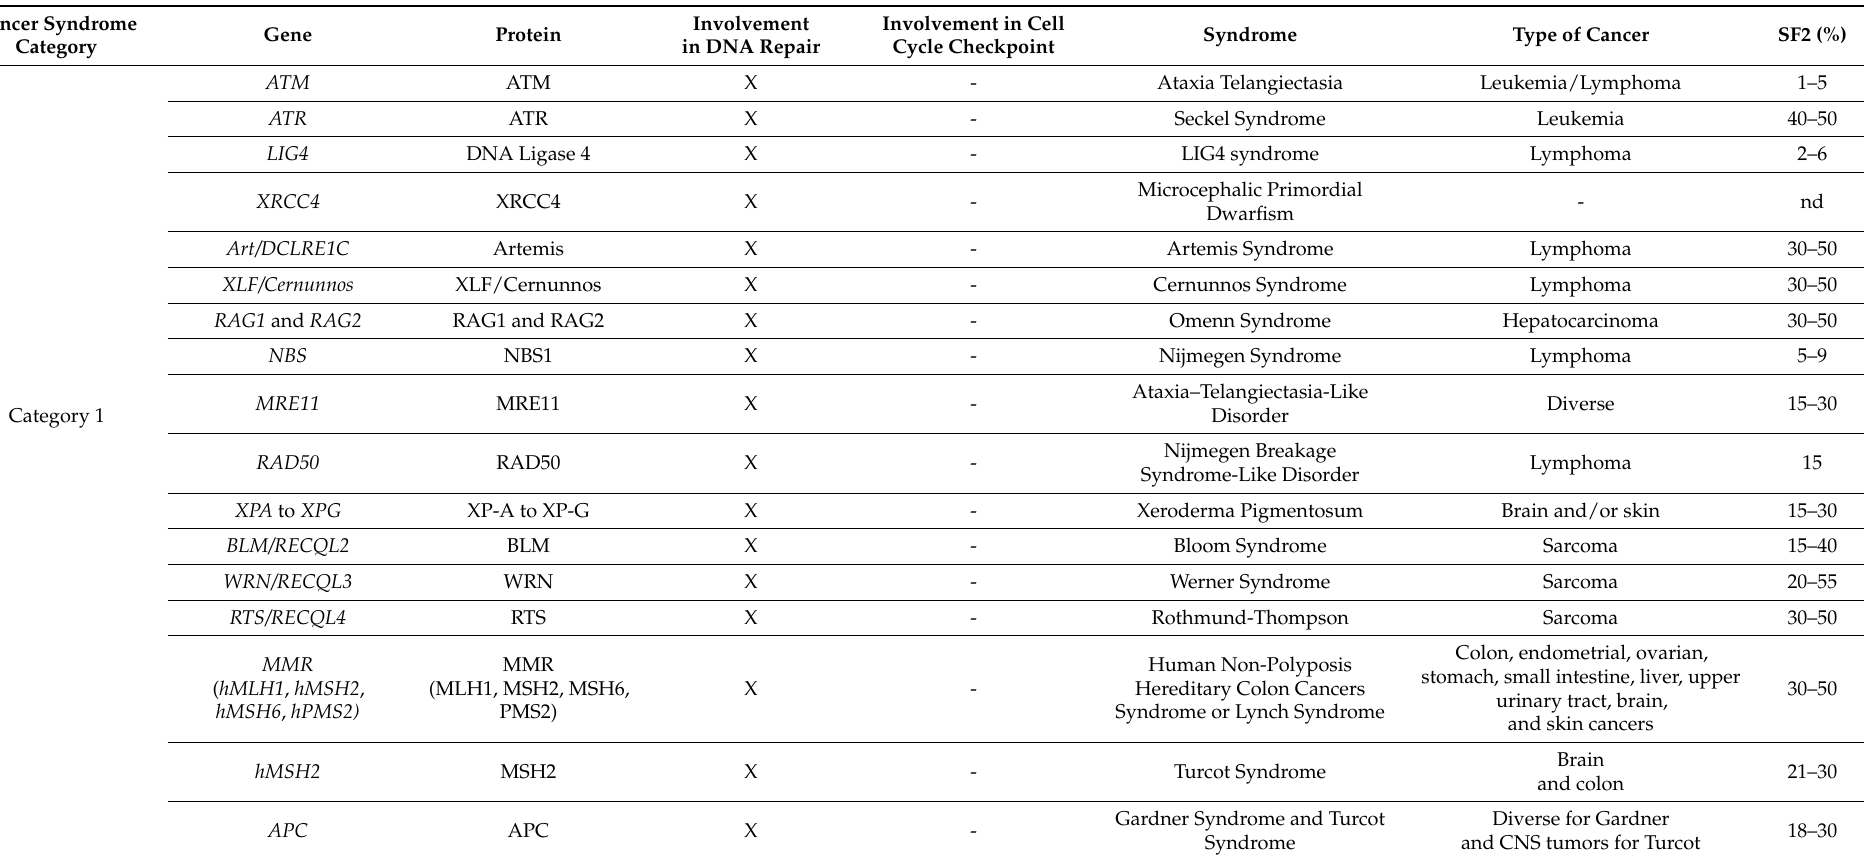
Table 1. Molecular and cellular features of the major syndromes associated with both cancer and individual